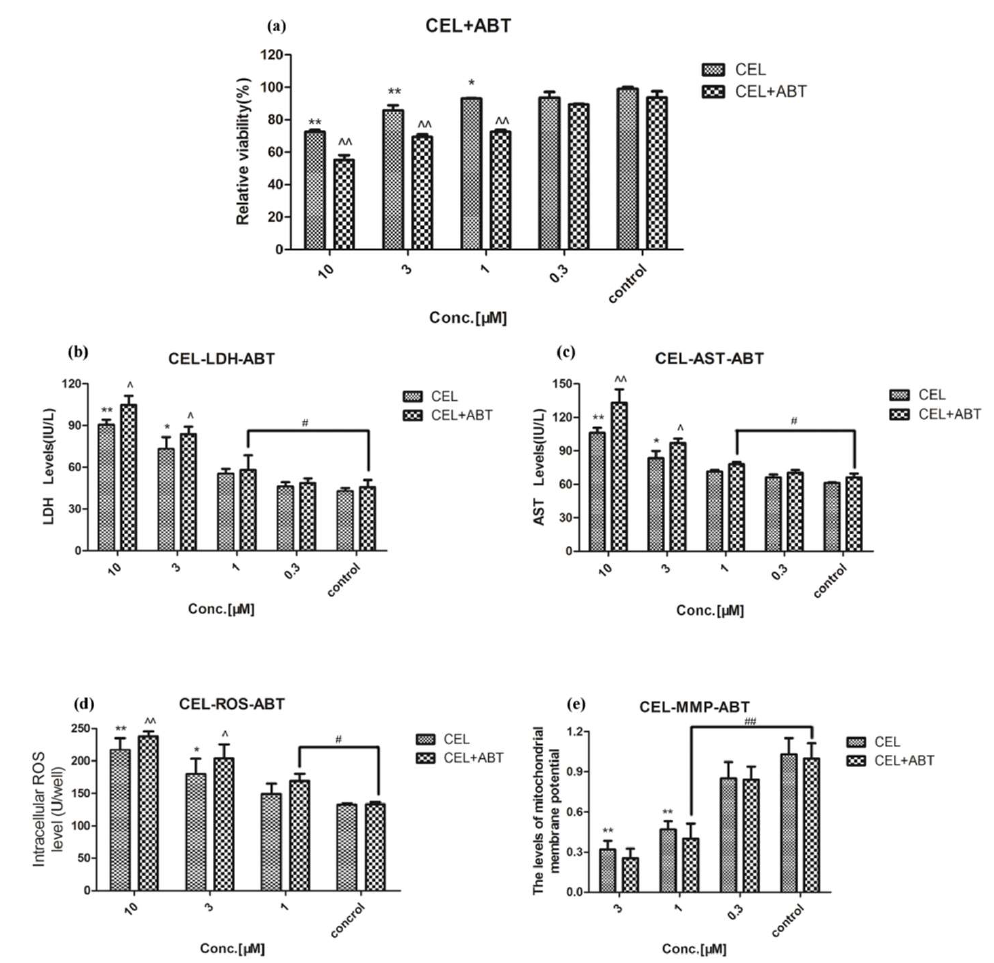
Figure 4. Influence of celastrol on the cell after preincubation with ABT. ( A ) The relative viability after treatment with a variety of concentrations of celastrol. ( B ), ( C ), ( D ) Cellular LDH, AST, and ROS productions after treatment with celastrol, respectively. ( E ) The MMP after treatment with different concentrations of celastrol. Compared with the control group, * p < 0.05, and ** p < 0.01; compared with the celastrol group, ^ p < 0.05, and ^^ p < 0.01; compared with ABT treated group, # p < 0.05, and ## p < 0.01.